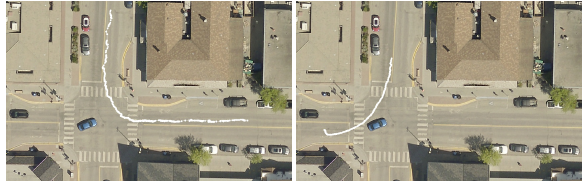
Figure 4. Individual vehicle trajectories